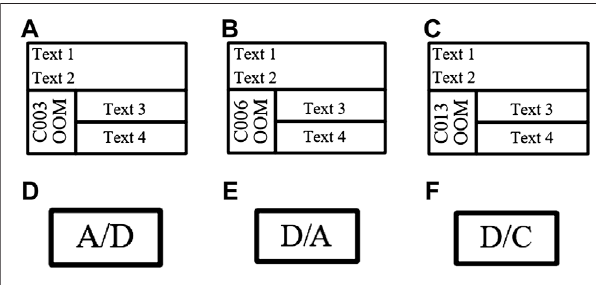
FIGURE 7 | Six common diagram elements in industrial control logic SAMAdiagram. (A) C003oom, (B) C006oom, (C) C013oom, (D) Ana2Dig, (E) Dig2Ana, and (F) Dig2Con.